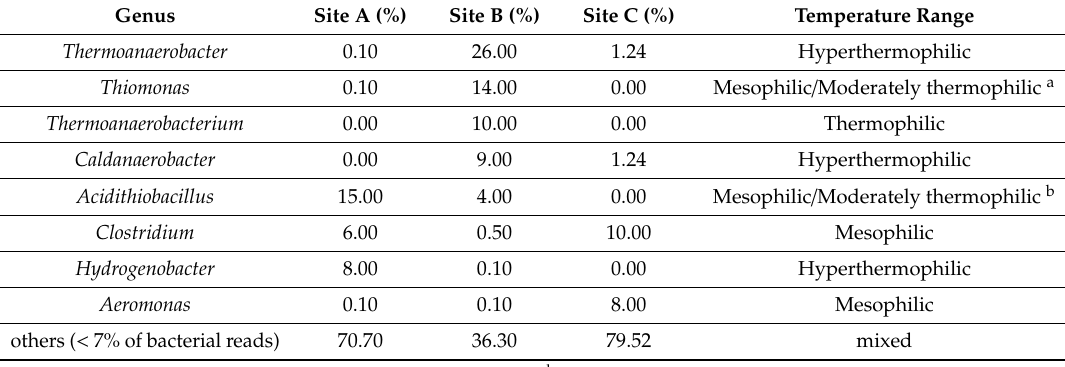
Table 1. Relative abundances of the bacteria communities in the Sites A, B, and